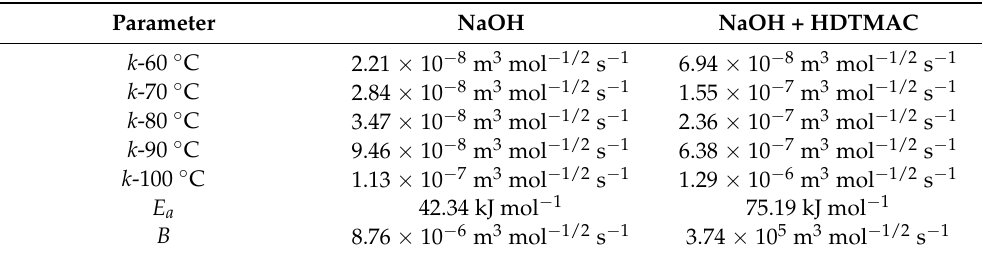
Table 4. The calculated rate constants: k , activation energy; E a and pre-exponential collision frequency factor B for PET